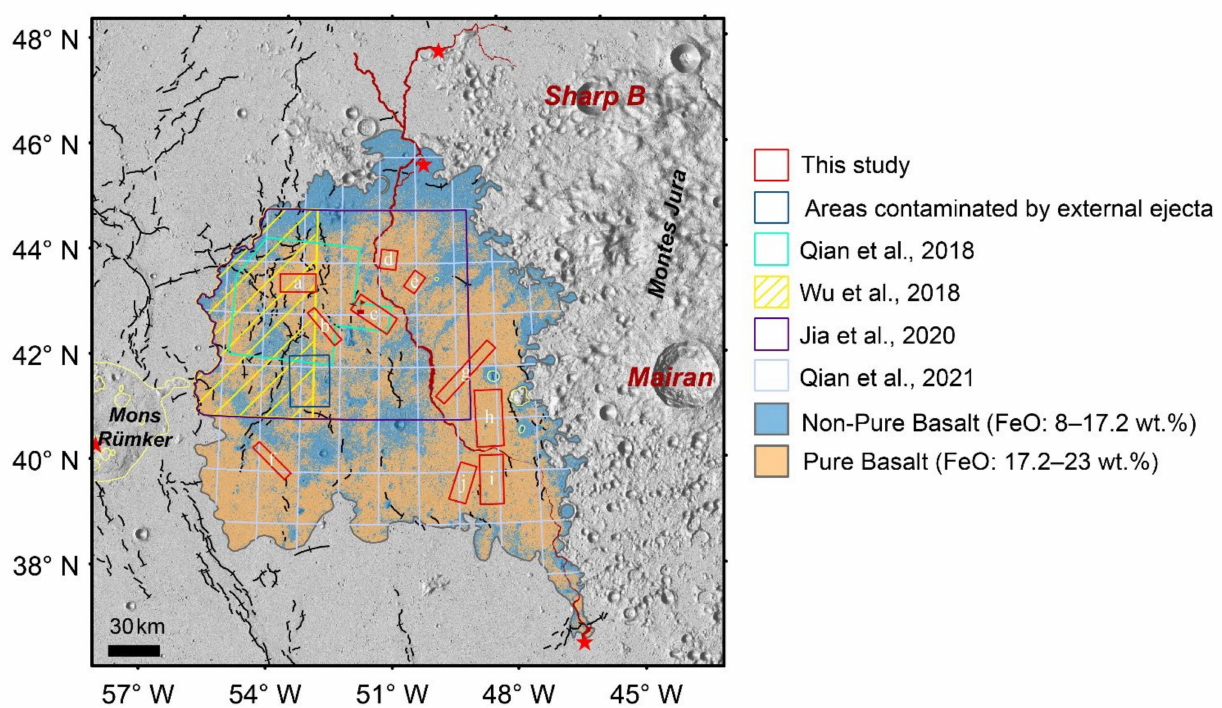
Figure 6. Crater counting areas of previous studies and this study. The pure basalt areas and non-pure basalt areas are